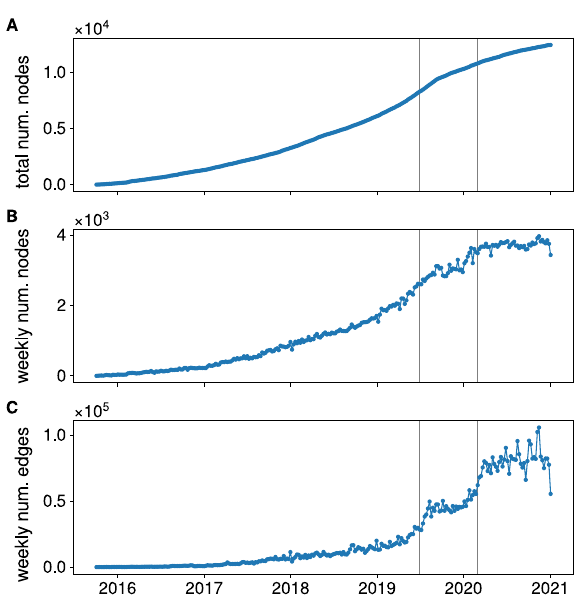
Fig. 1 Evolution of the network of Telegram public channels/groups related to the far-right movement. We show the cumulative number of nodes in the network ( A ) and the weekly number of unique nodes ( B ) and edges ( C ) in the network. The gray vertical lines indicate July 1st, 2021 and March 1st 2022 corresponding to the separation in three datasets we